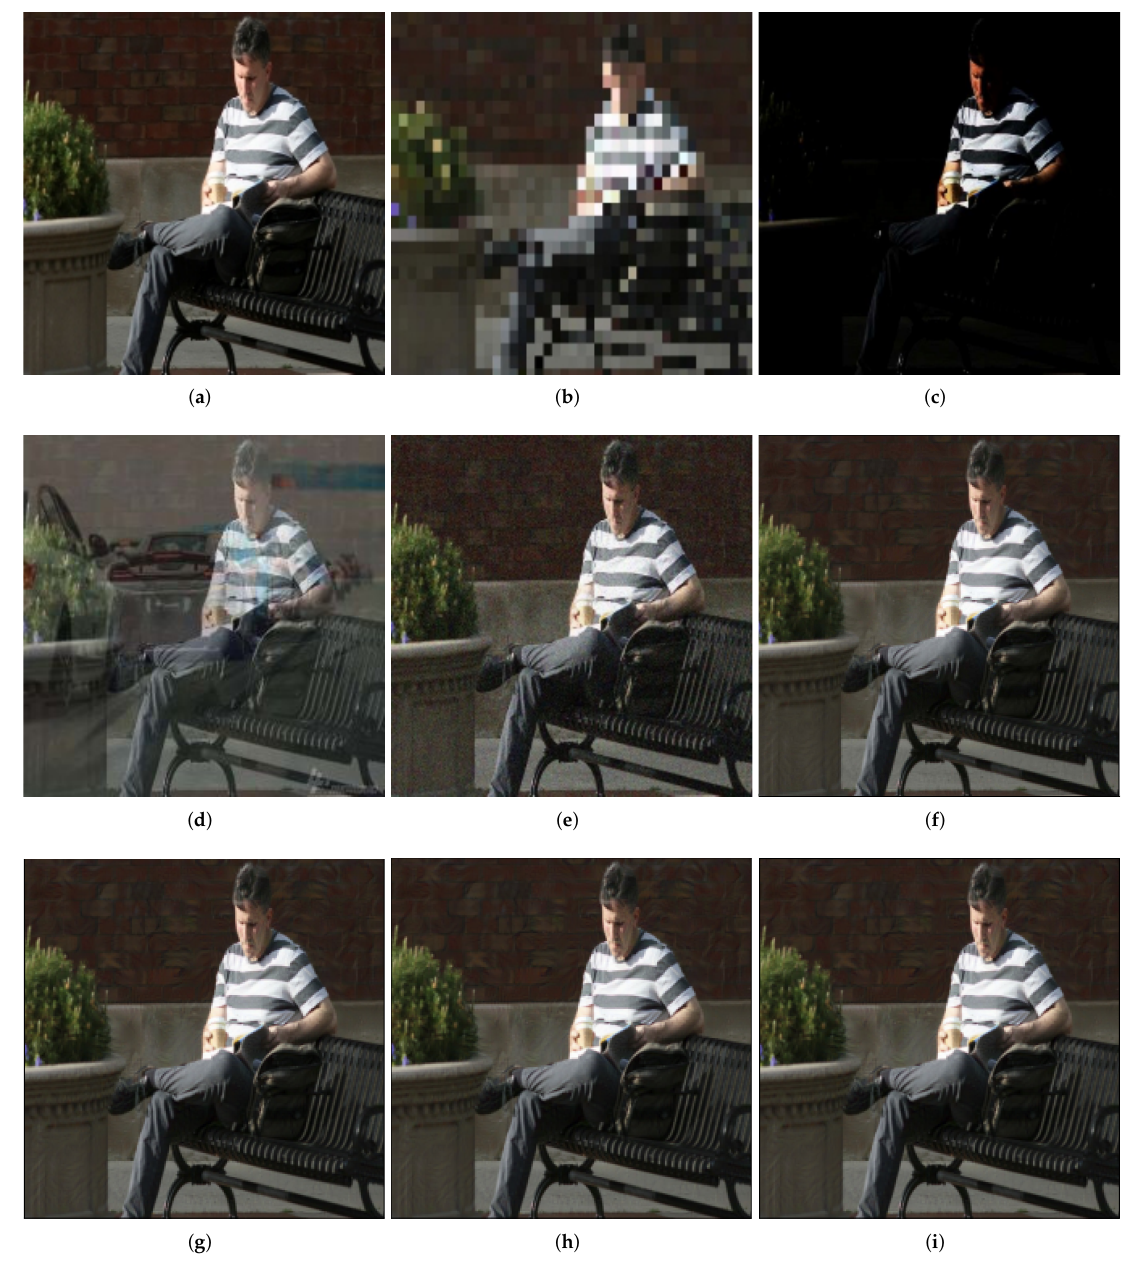
Figure 3. Examples under the action of traditional privacy-preserving strategies, such as mosaic ( b ), brightness ( c ), transparency ( d ), and noise ( e ). We also show examples of adversarial attacks when τ = [0.01, 0.02, 0.03, 0.04]. We demonstrate visual quality and the effect of privacy-preserving via the PSNR metric and MAP. ( a ) Original images, MAP=91%; ( b ) mosaic, PSNR = 16.66 dB, MAP = 23%; ( c ) brightness, PSNR = 13.02 dB, MAP = 89%; ( d ) transparency, PSNR = 18.28 dB, MAP = 88%; ( e ) noise, PSNR = 24.53 dB, MAP = 90%; ( f ) τ = 0.01, PSNR = 44.45 dB, MAP = 20%; ( g ) τ = 0.02, PSNR = 43.51 dB, MAP = 19%; ( h ) τ = 0.03, PSNR = 43.32 dB, MAP = 17%; ( i ) τ = 0.04, PSNR = 43.22 dB, MAP =